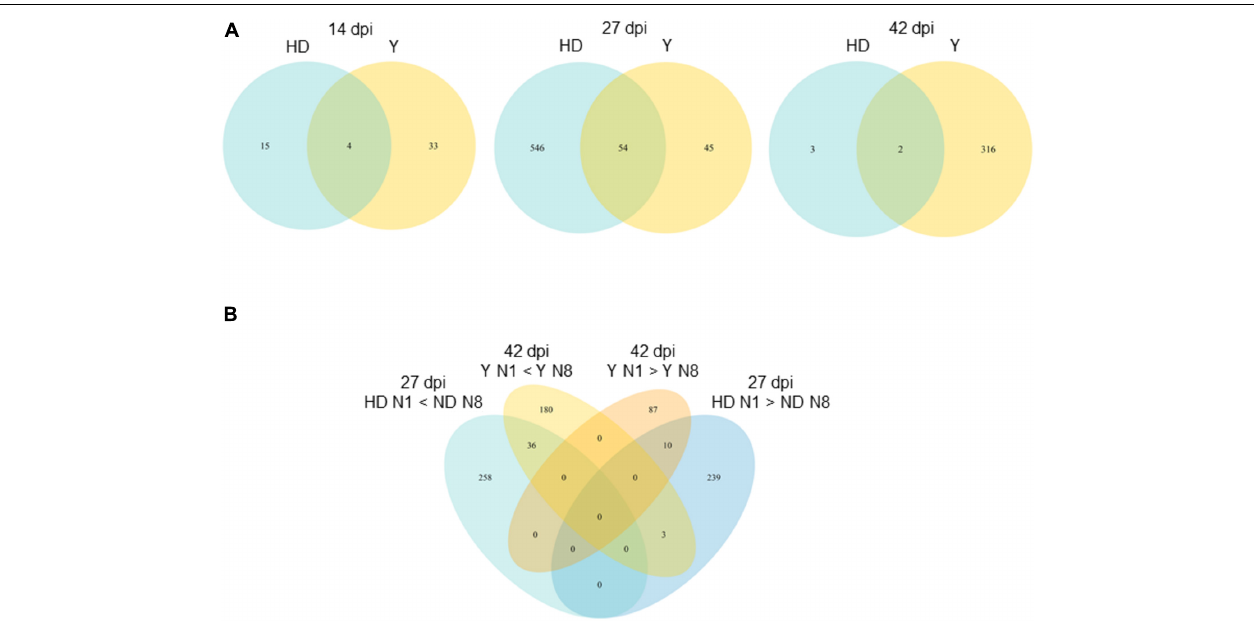
FIGURE 5 | Number of Plasmodiophora brassicae DEGs between N1 and N8 according to the host genotype. The Venn diagrams show the number of significantly DEGs ( P < 0.05) between N1 and N8 for each host B. napus genotype at each sampling date (A) , and for both genotypes between sampling dates (B) . DEGs, differentially expressed genes; dpi, days post-inoculation; Y, Yudal genotype; HD, HD-018 genotype; N1, 1 mM nitrogen supply; N8, 8 mM nitrogen supply.